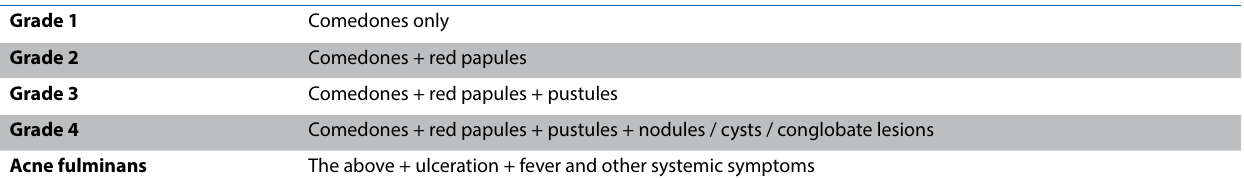
Table 2. Grading of acne